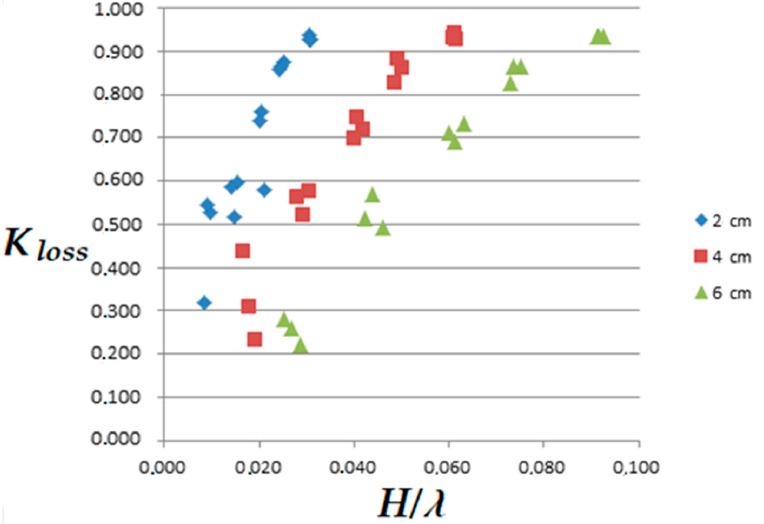
Figure 8. Relationship between wave steepness and energy loss coe ffi cient, water depth a = 0.3 m.